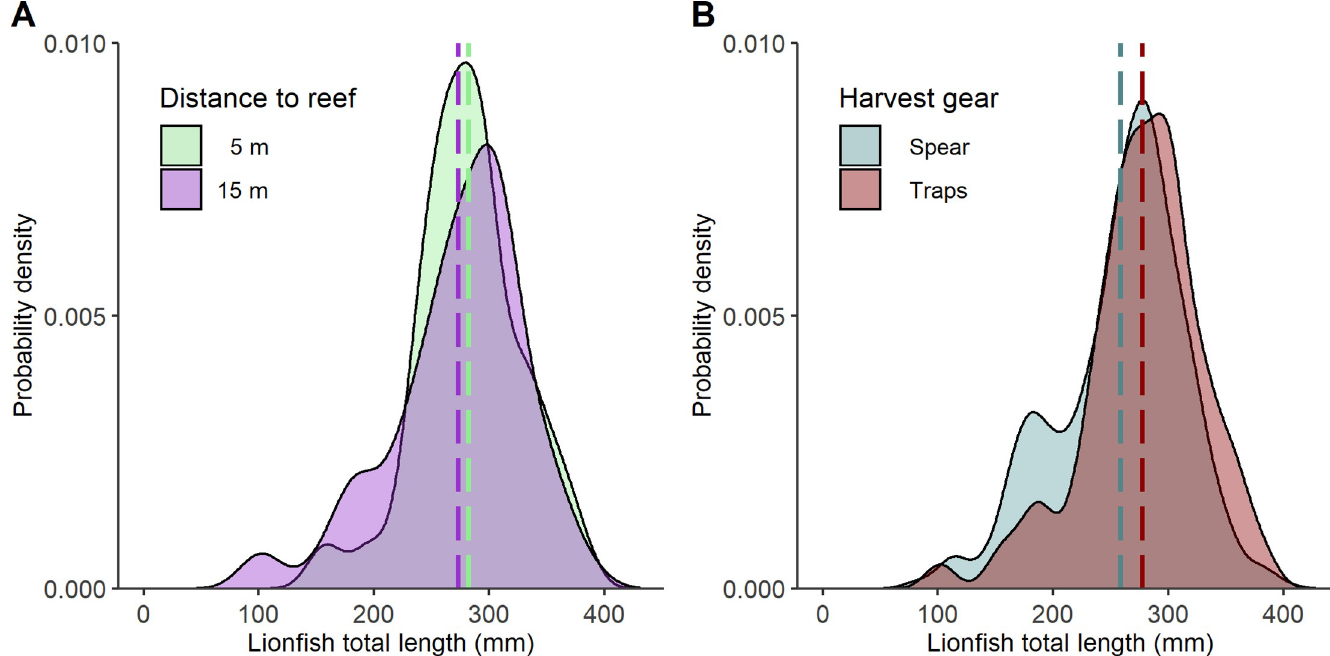
Fig 6. Lionfish size distributions by distance to reef and harvest gear. A) Lionfish total length (TL) probability density distributions for lionfish captured in Gittings traps deployed at 5 m and 15 m distances to the adjacent artificial reef. B) Lionfish TL distributions for lionfish harvested by Gittings traps (all treatments) and lionfish sampled concurrently (June–December 2018) by spearfishing on similar northern Gulf of Mexico artificial reefs. Mean TL per distribution is indicated by a vertical dashed line.